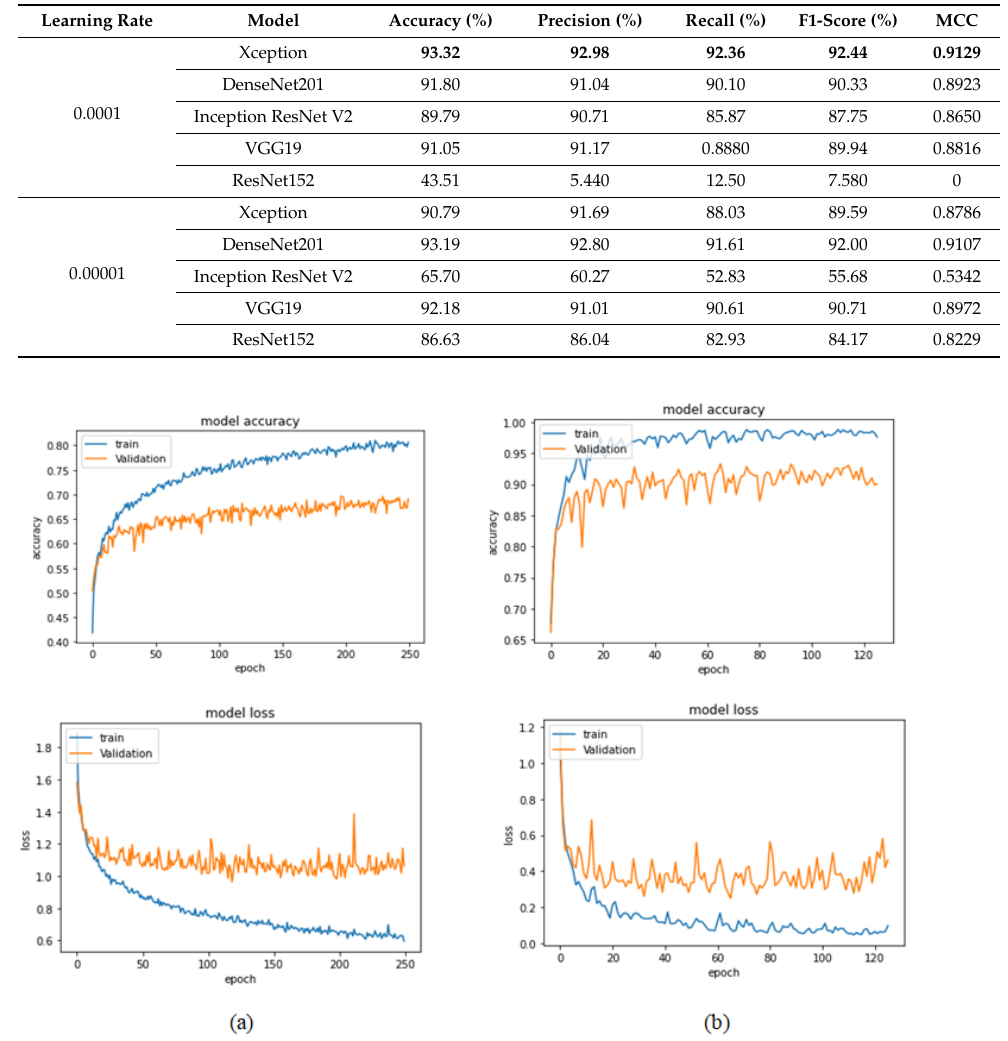
Figure 21. Learning curves for Xception at 0.0001 learning rate in magnification-independent multi- classification. ( a ) Accuracy and loss curves of Phase 1 of training. ( b ) Accuracy and loss curves of Phase 2 of training.